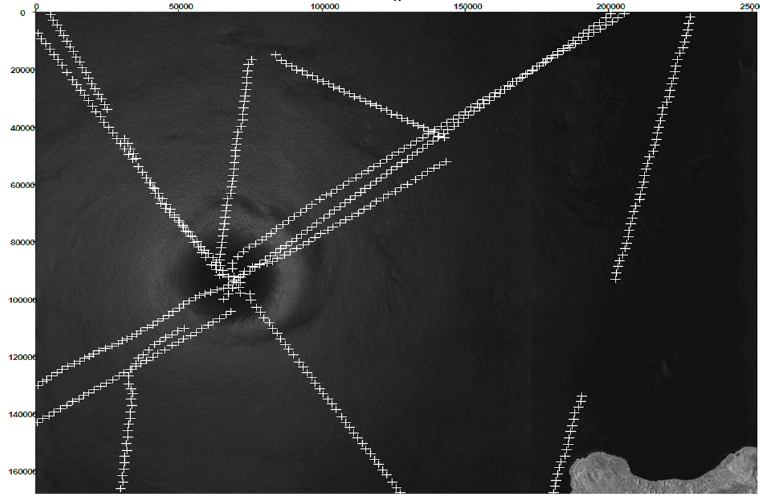
Figure 8. The track of the aircraft over hurricane Irma superimposed on the Sentinel-1 image 2017/09/07.